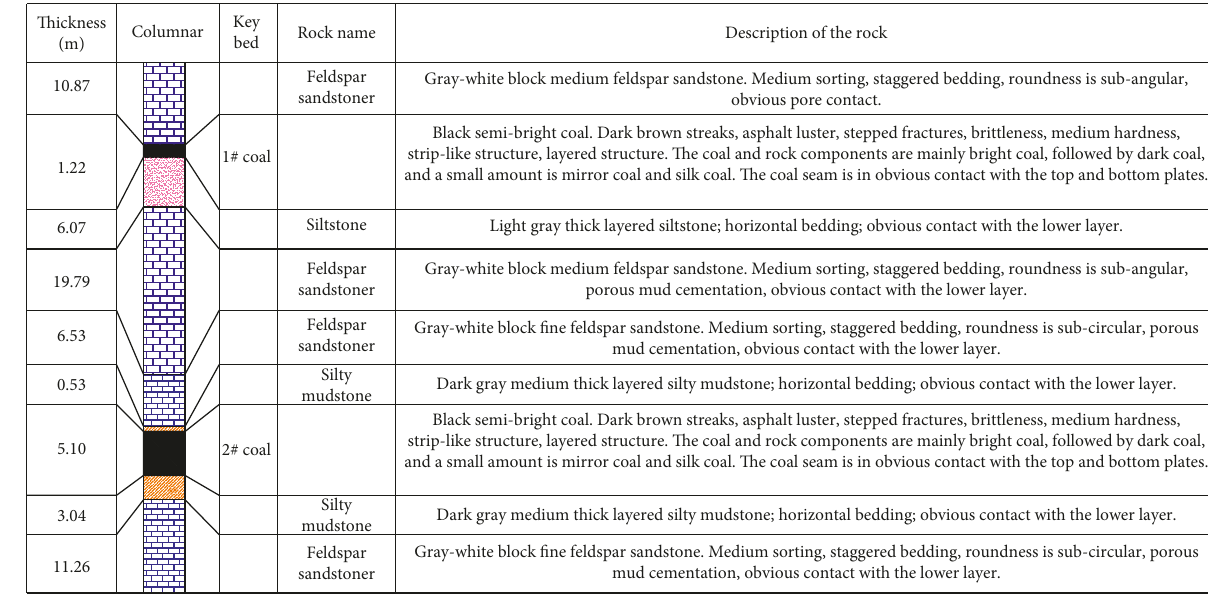
Figure 2: Composite borehole columnar section for 11215 working face.